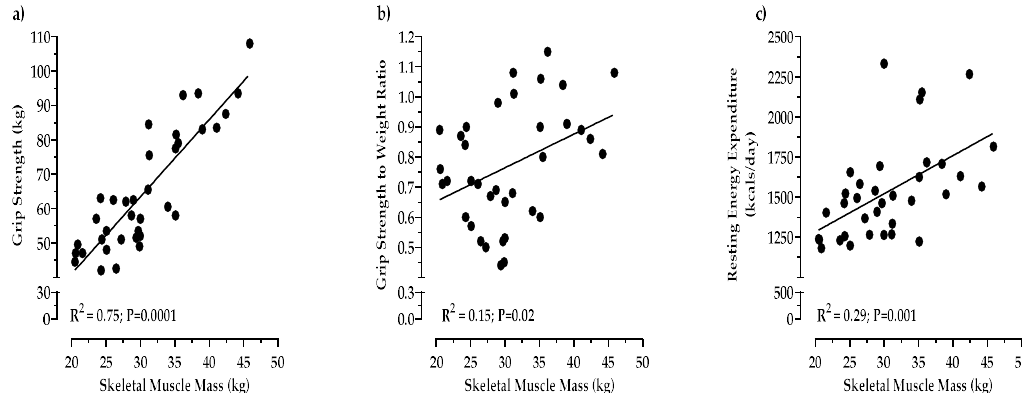
Figure 1. Bivariate correlations at study-end between skeletal muscle mass and handgrip strength ( a ), handgrip strength to body weight ratio ( b ), and resting energy expenditure ( c ).